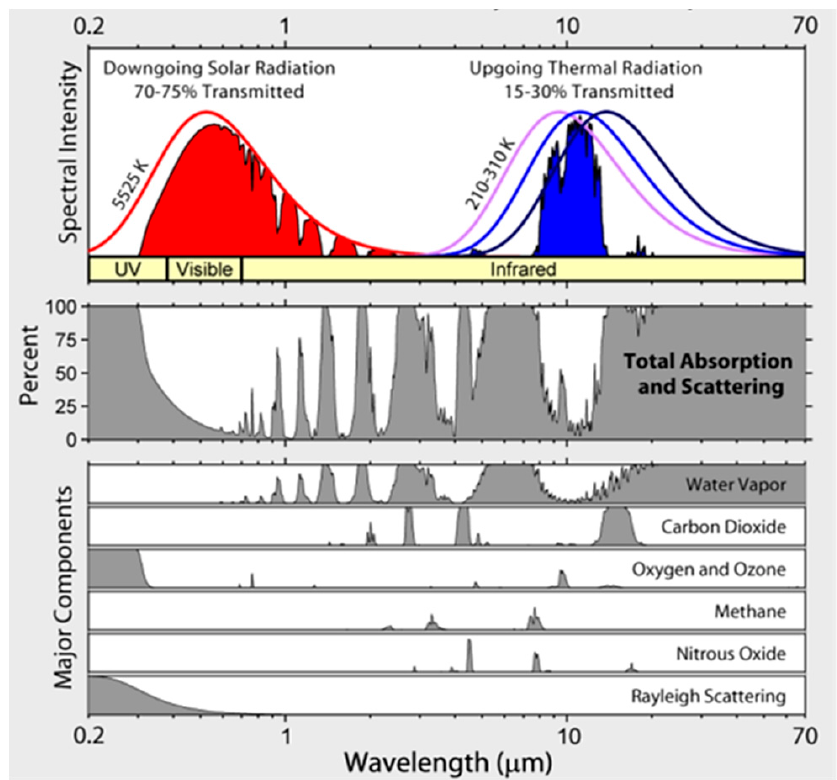
Figure 2. Thermal radiation transmission by the atmosphere [25]. The principle of PRC relies on the fact that the atmosphere transmits about 87% of the outgoing radiation from the Earth in the “atmospheric window” region. Surfaces can exchange heat with cold space (3 K) through this atmospheric window region. If surfaces (or participating gases, for that matter) experience a mismatch between outgoing and incoming thermal radiation, they can reach a lower steady-state temperature than the ambient due to strong emission in this wavelength region and strong reflection outside of it [26]. Fortunately, the wavelength of the atmospheric window falls within the black body’s peak thermal radiation region at room temperature (300 K), as defined by Plank’s law. This property allows a passive cooling mechanism for a terrestrial body to operate at room temperature by removing heat through the atmospheric window. The Earth’s atmosphere acts as a huge thermal reservoir that allows radiation to escape into space directly. Conse- quently, any terrestrial object with a high emissivity in the atmospheric window can radiate heat into space effectively. Even so, a number of factors, such as geographical location, cloudiness, and humidity levels, affect atmospheric window transmittance. When the sky is clear and dry, the atmospheric window transmittance is high